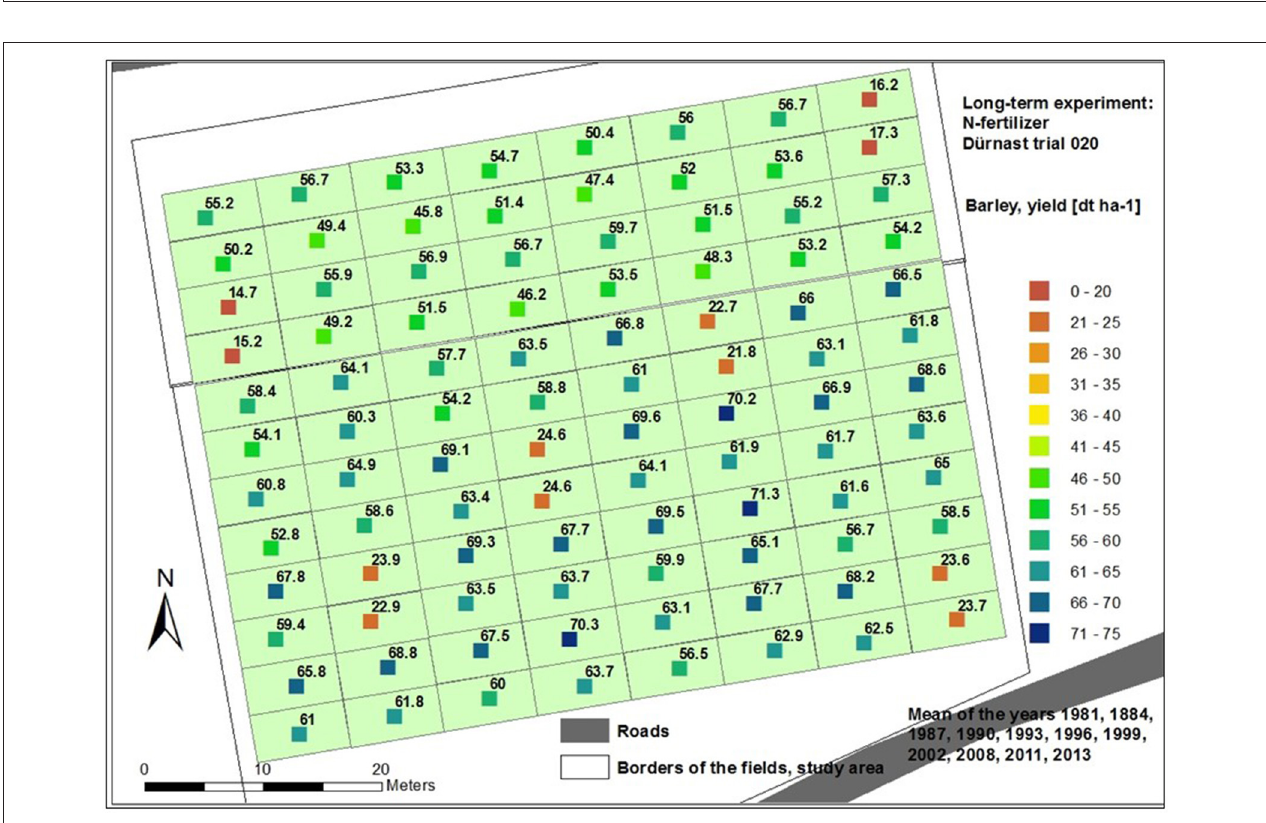
FIGURE 4 | Georeferenced multi-annual yields of barley (plot wise means) of the years 1981–2013.